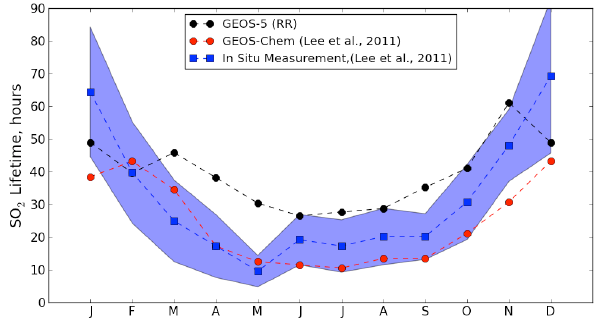
Fig. 3. GEOS-5/GOCART monthly SO 2 lifetime for the year 2010 compared to the study made by Lee et al. (2011) for the year 2006 over the eastern United States (35.2–44.5 ◦ N, 68.4–81.6 ◦ W) during daytime.